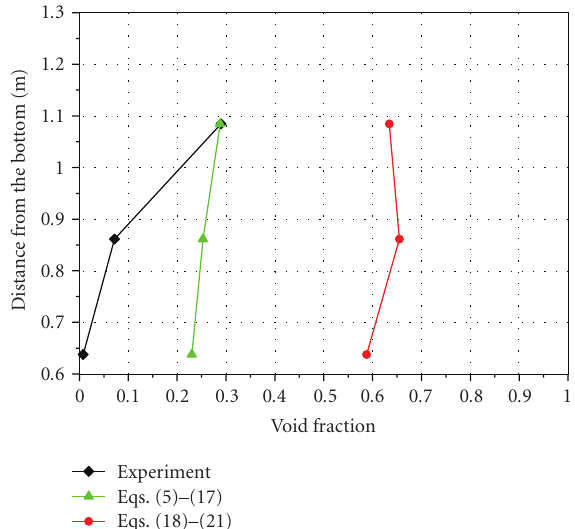
Figure 5: Void fraction profile along height of the central down- comer in the experiment and in the calculations with the use of the models (5)–(17) and